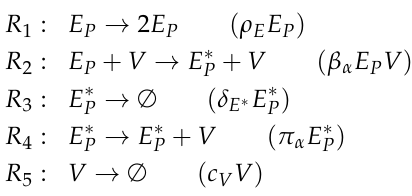
Figure A2. Reactions of Miao model [14].